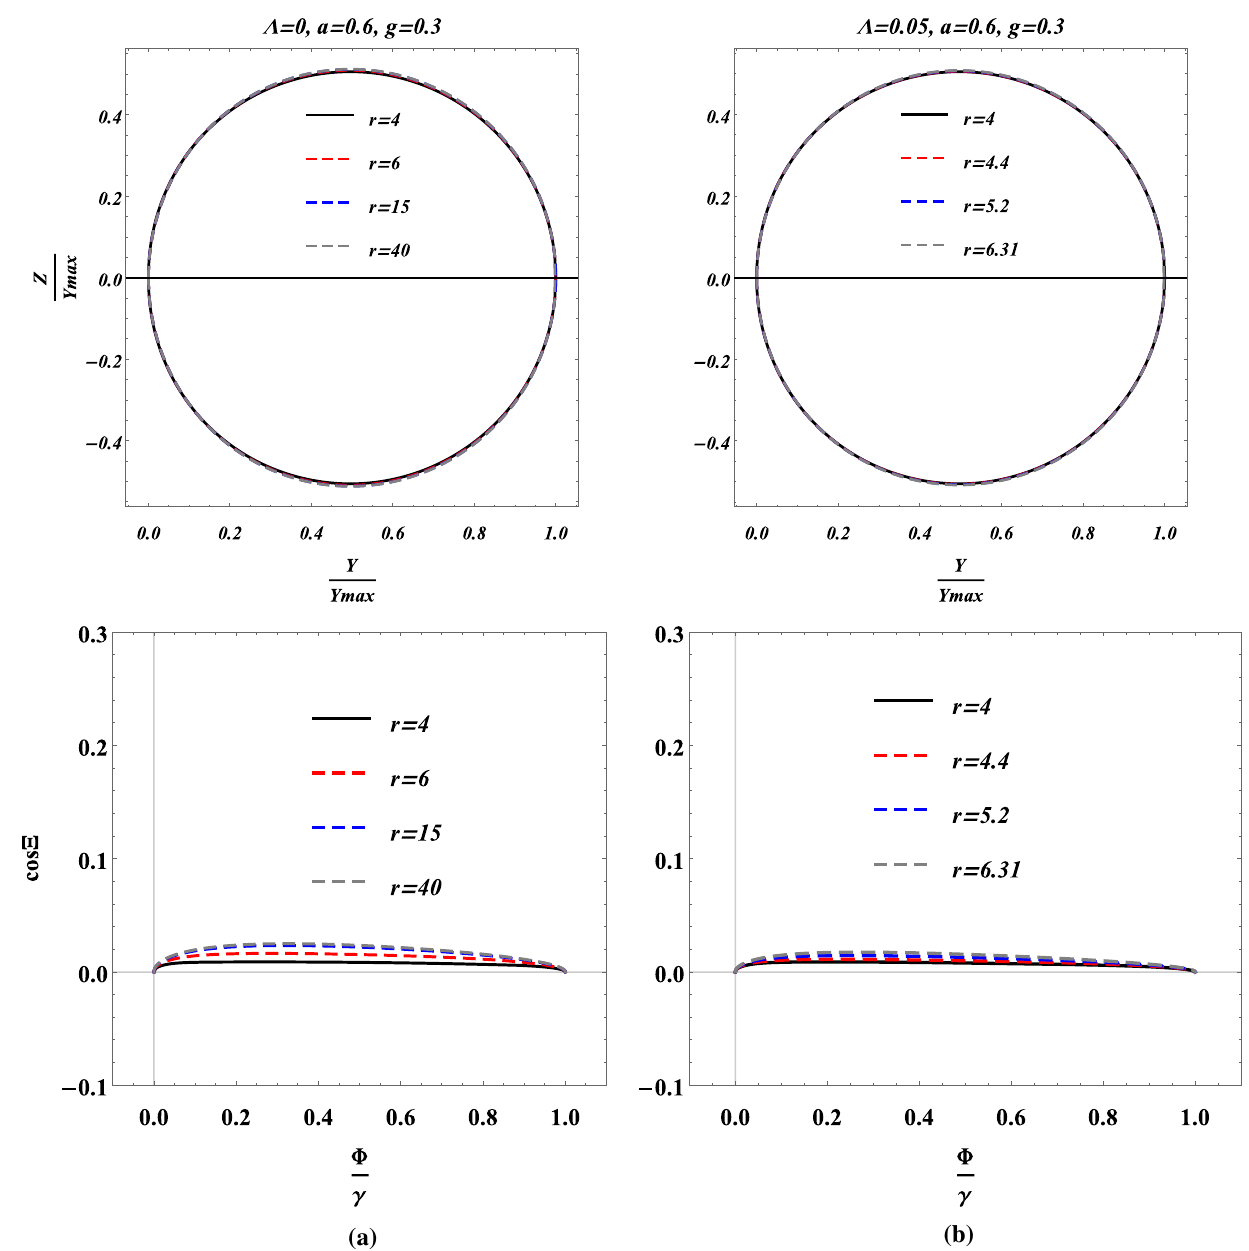
Fig. 10 The shapes of shadows and corresponding distortion parameters (cid:15) as function of (cid:13) γ for observers at selected position r